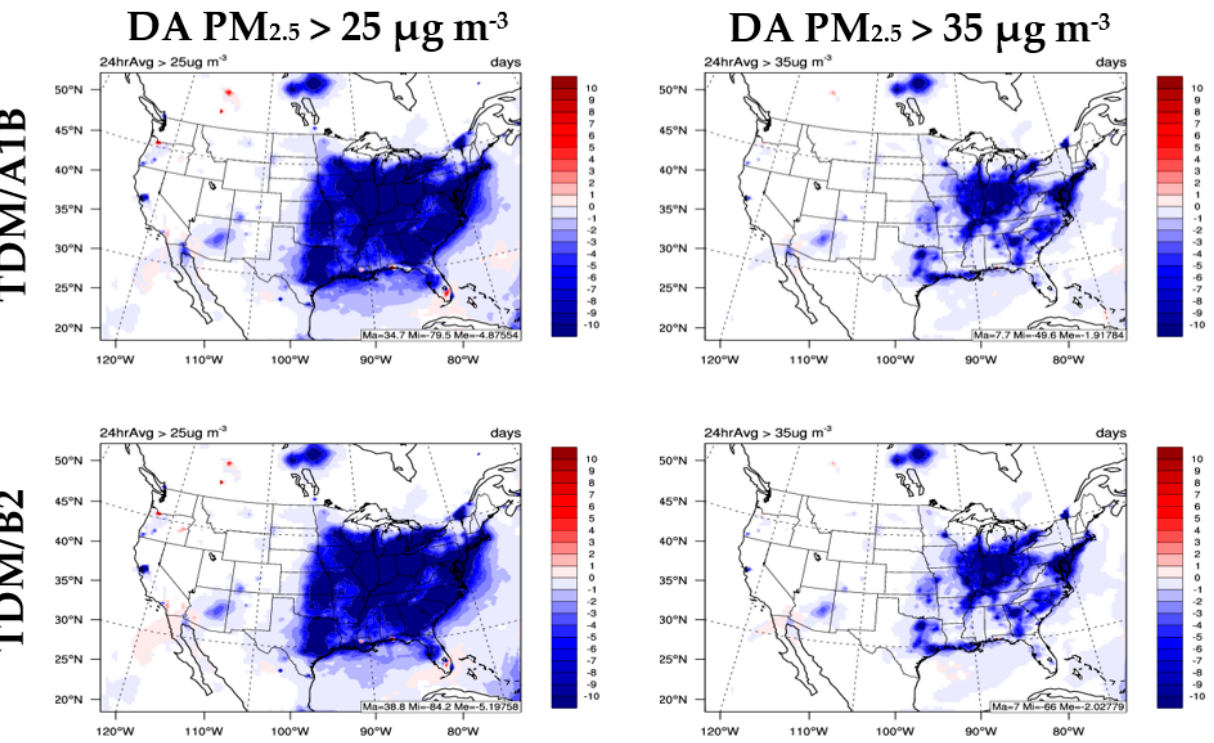
Figure 6. Absolute changes of average number of exceedance days of 24-h daily averaged (DA) PM 2.5 against a threshold of 25 µg m − 3 and 35 µg m − 3 between the future and current decade for TDM/A1B and TDM/B2.